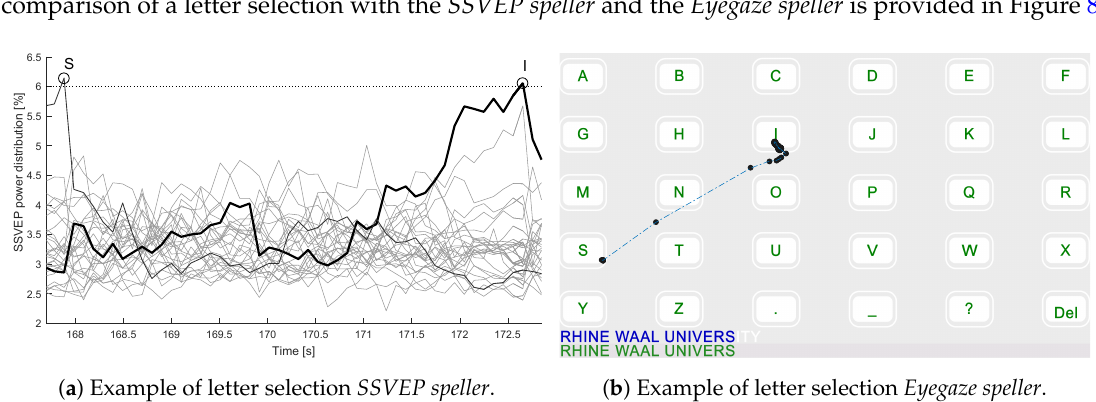
Figure 8. Comparison of the the steady-state visual evoked potentials based application ( SSVEP speller ) and the eye tracking based application ( Eyegaze speller ) during selection of the letter “I” in the example of subject 1. ( a ) The SSVEP power estimations are displayed as a function of time. The black line represents the SSVEP power of the frequency corresponding to the letter “I”. If a certain threshold value (in this case 6) was surpassed, an output command was classified; ( b ) Eye-movement path from the letter “S” to “I”. When the eye focused sufficiently long (1 s) on the desired box, the letter was selected. Before selection, the eye tracker recorded several gaze positions along the path from “S” to